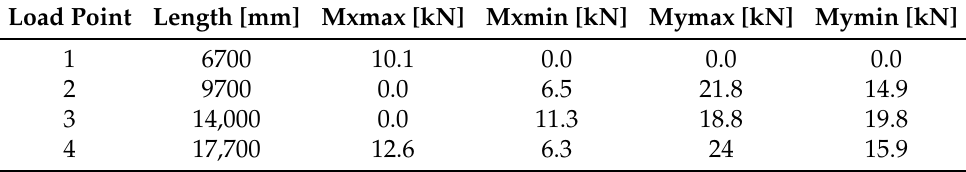
Table 1. Applied loads measured by load cells for all the bending load